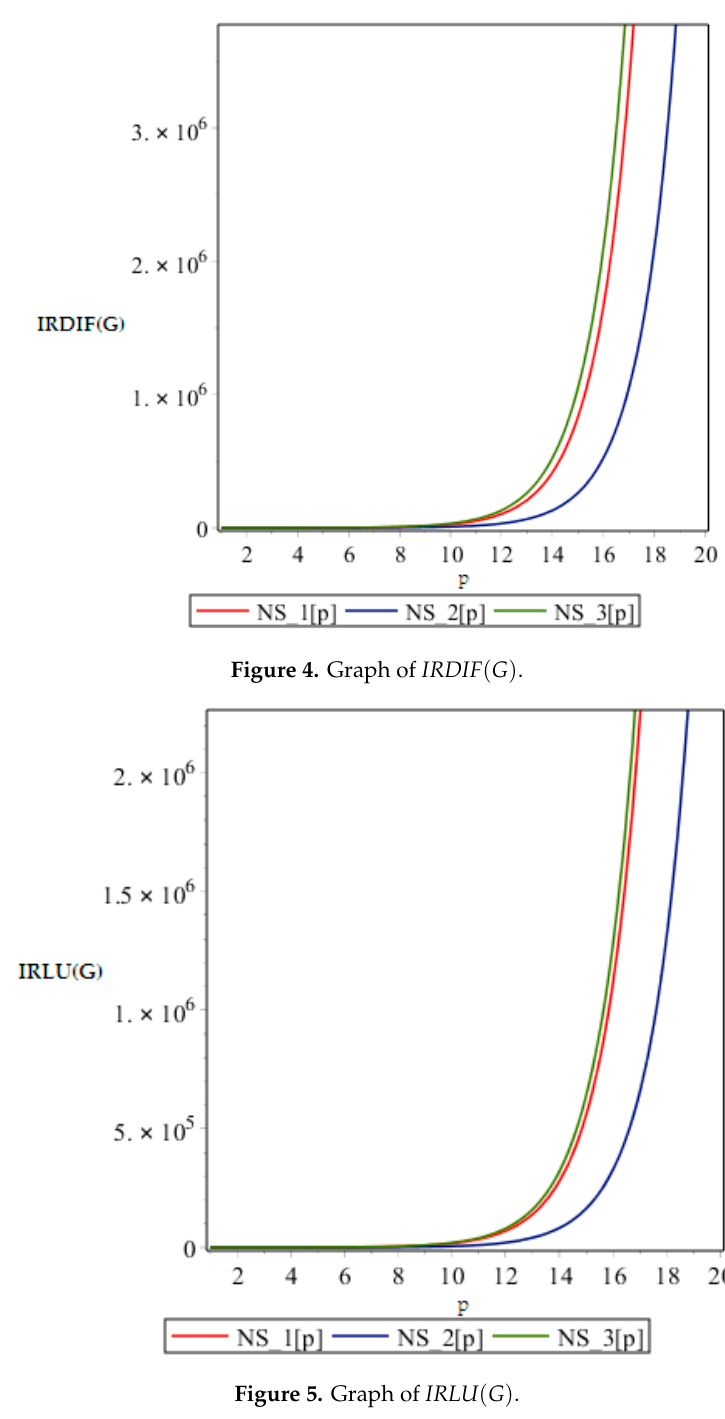
Figure 5. Graph of IRLU ( G ) Figure 5. Graph of 𝐼𝑅𝐿𝑈(𝐺) .